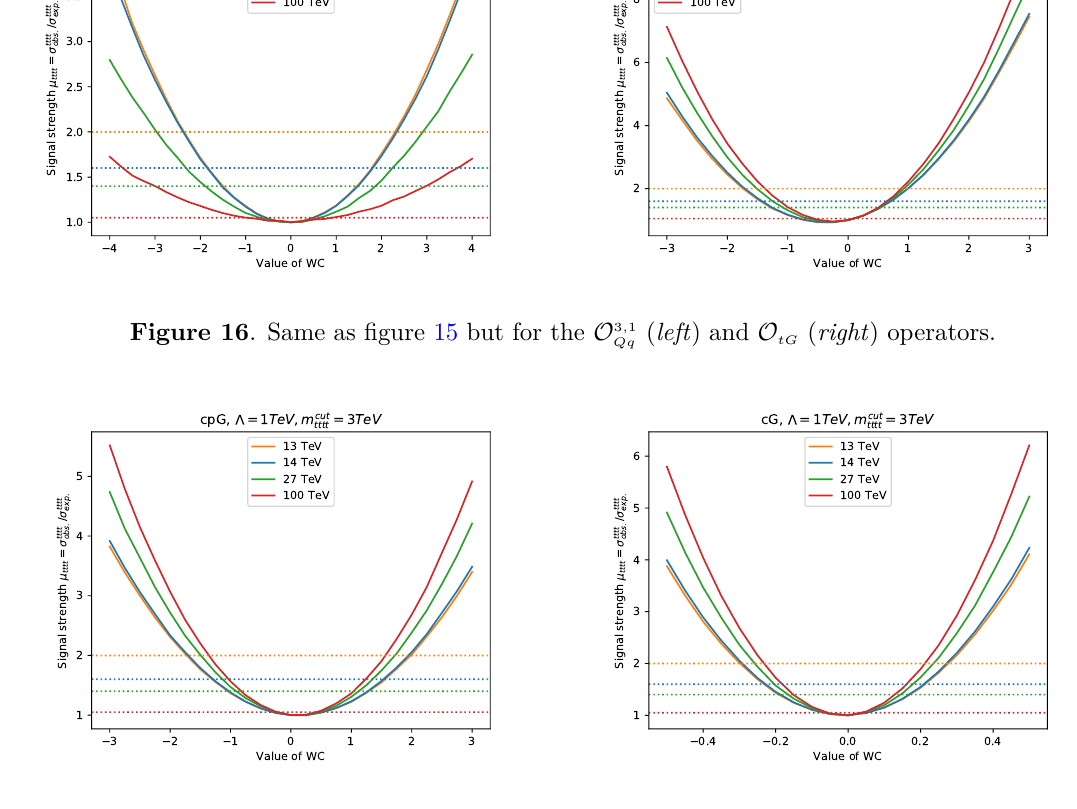
( left ) and O ( right ) ϕG G